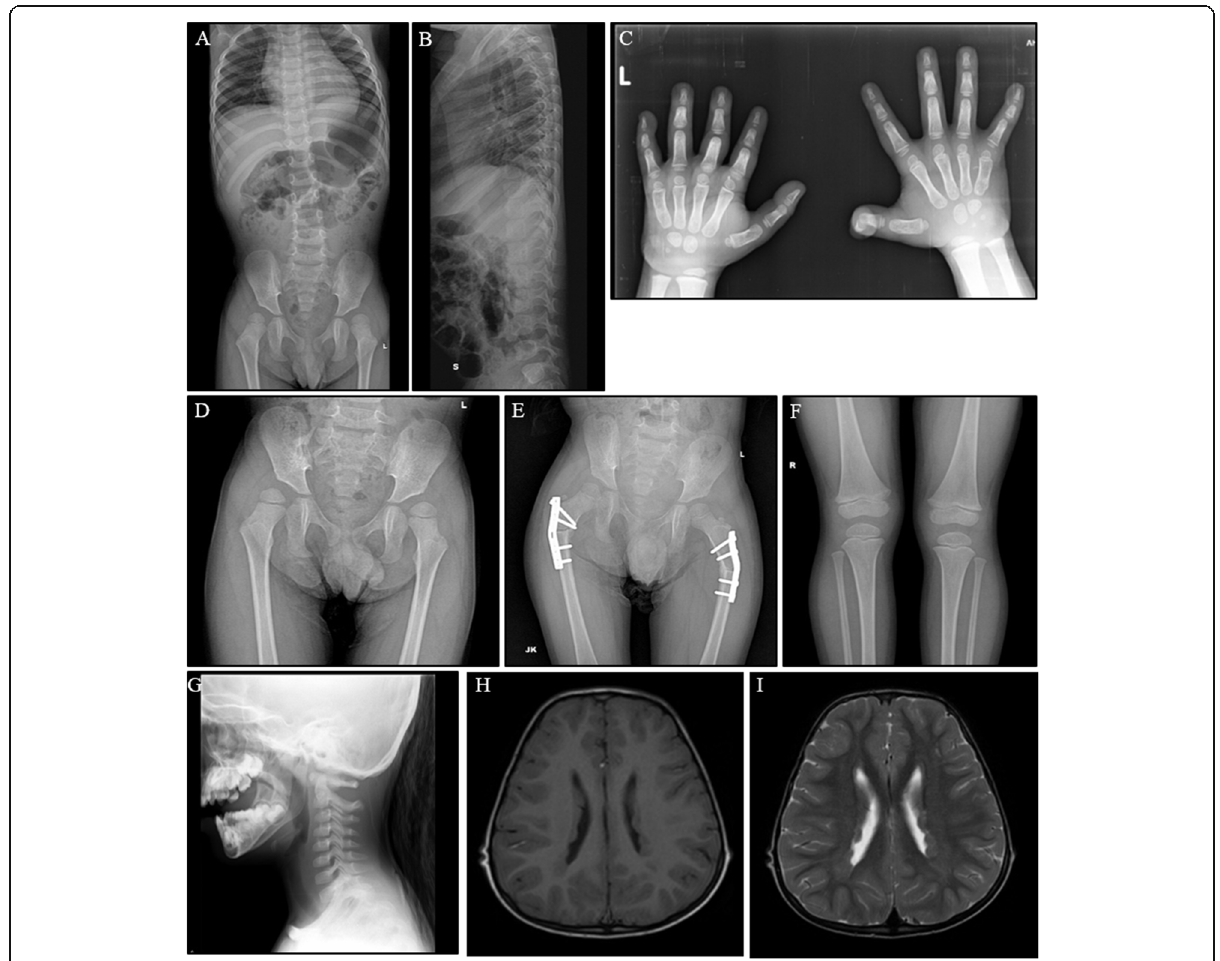
Fig. 3 Skeletal survey of five-year old Indian patient (case A). a , b , g At 5 years of age the skeletal survey revealed tall vertebral bodies, c delayed ossification of carpal bones, dislocated terminal phalanx of right thumb, d , e bilateral hip subluxation for which he underwent bilateral varus derotation osteotomy, f genu recurvatum and ( h , i ) magnetic resonance imaging of the brain showed PVNH along the subependymal regions